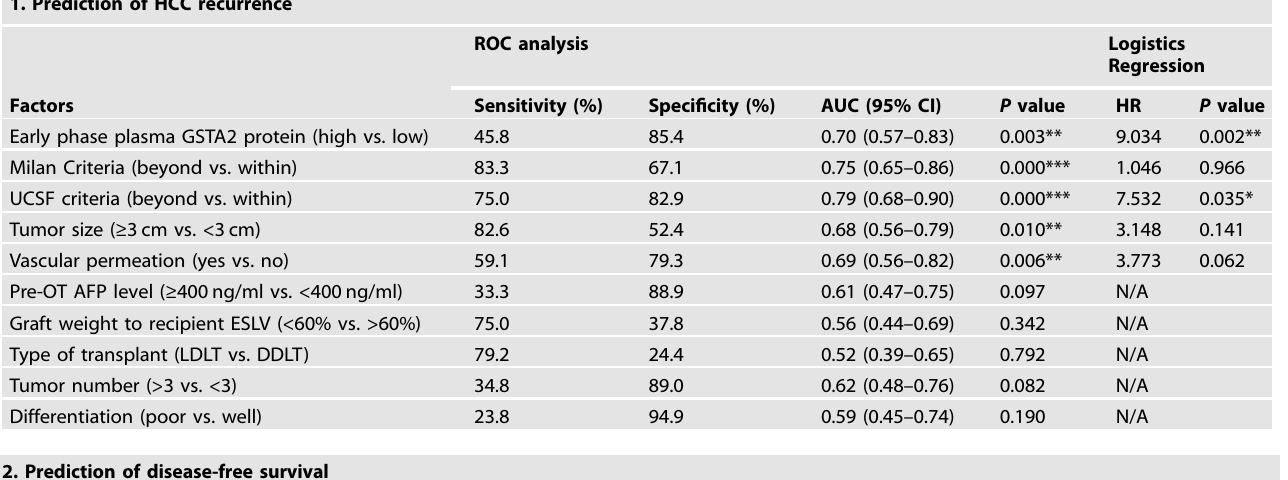
Table 2. Prognostic value of early phase circulating GSTA2 protein in HCC recipients after liver transplantation. 1. Prediction of HCC